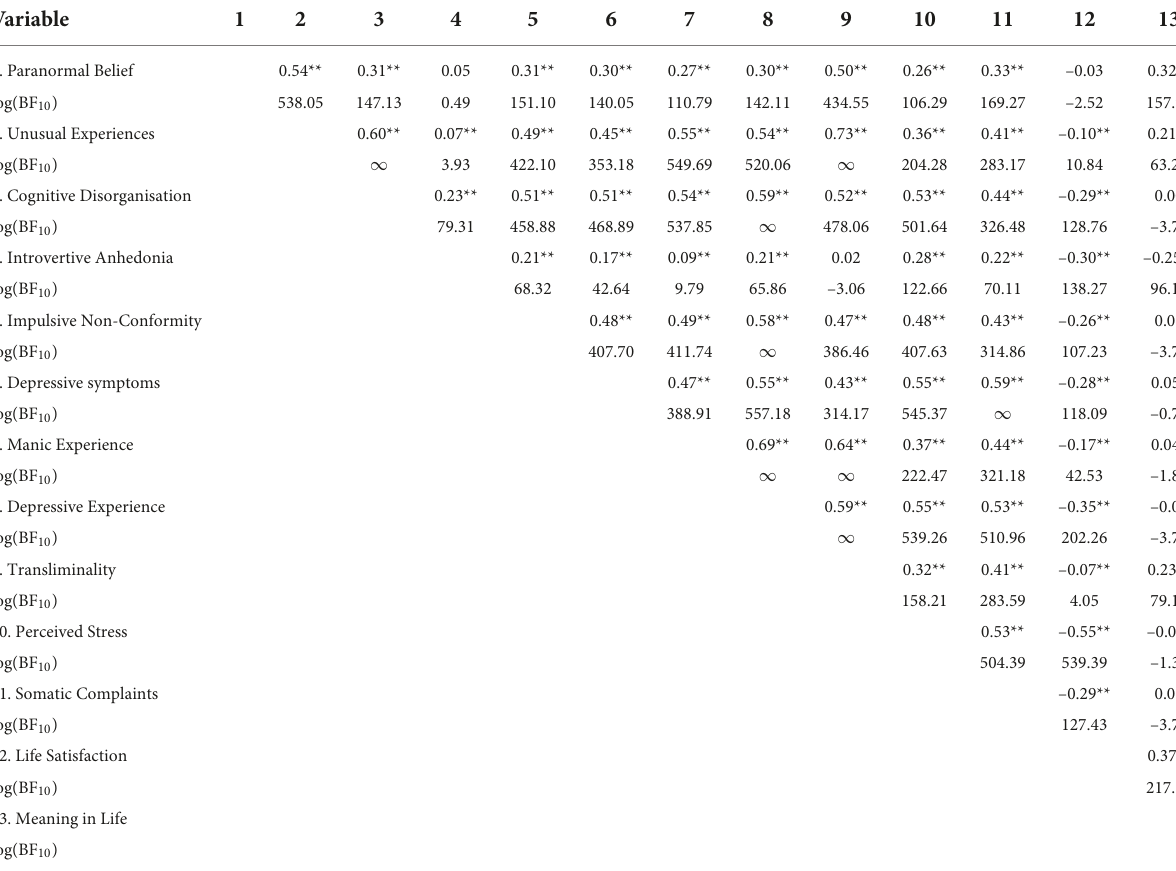
TABLE 1 Correlations among study